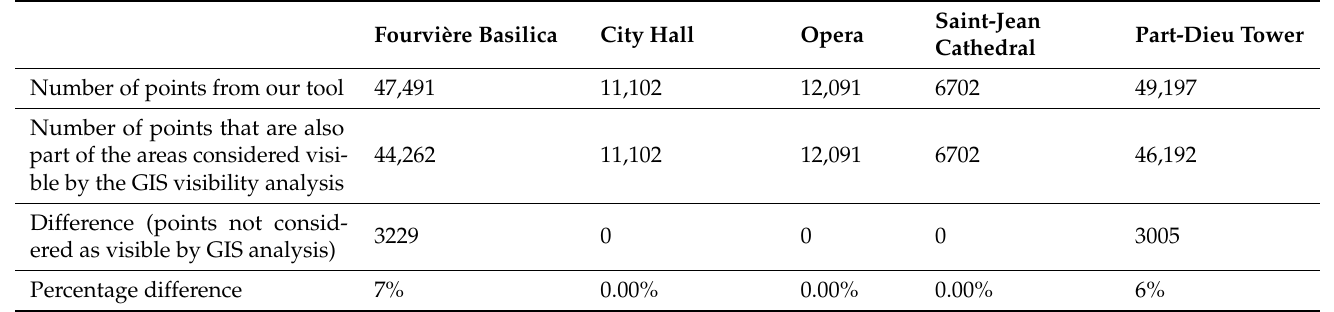
Table 5. Results from the comparison for points beyond 1 km between our analysis and a raster analysis from different landmarks in the Lyon